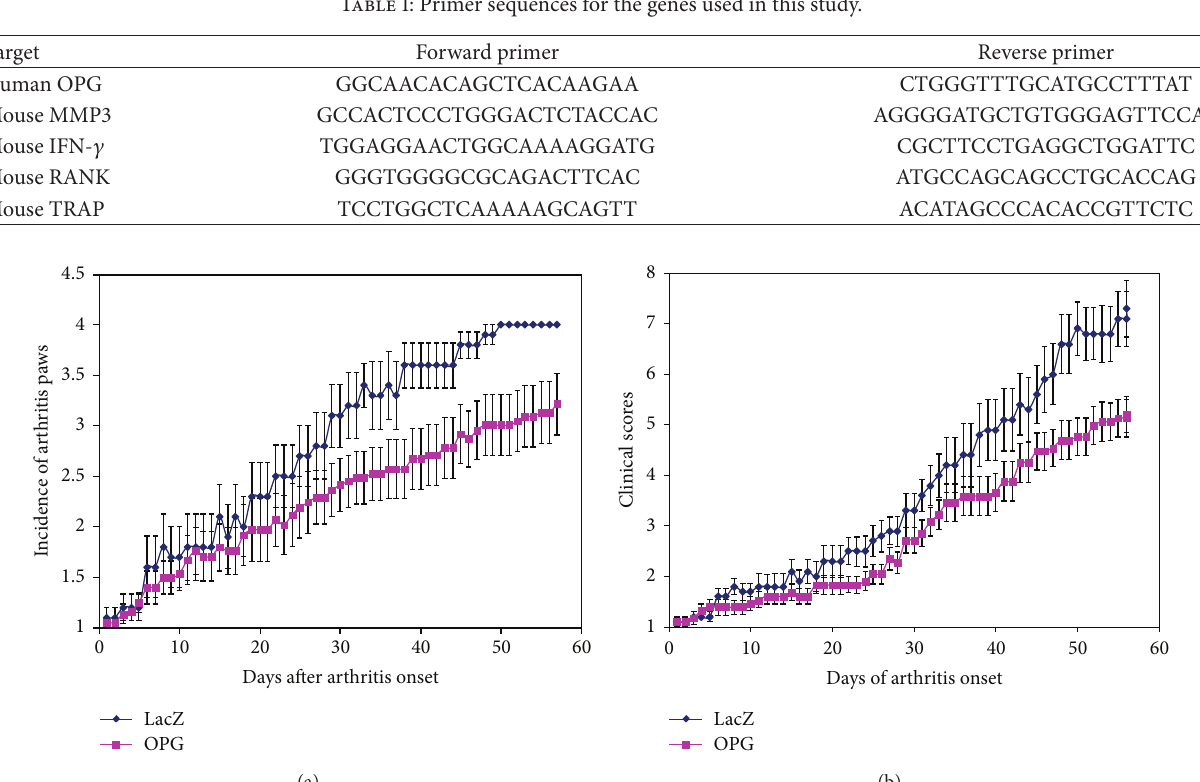
Table 1: Primer sequences for the genes used in this study.